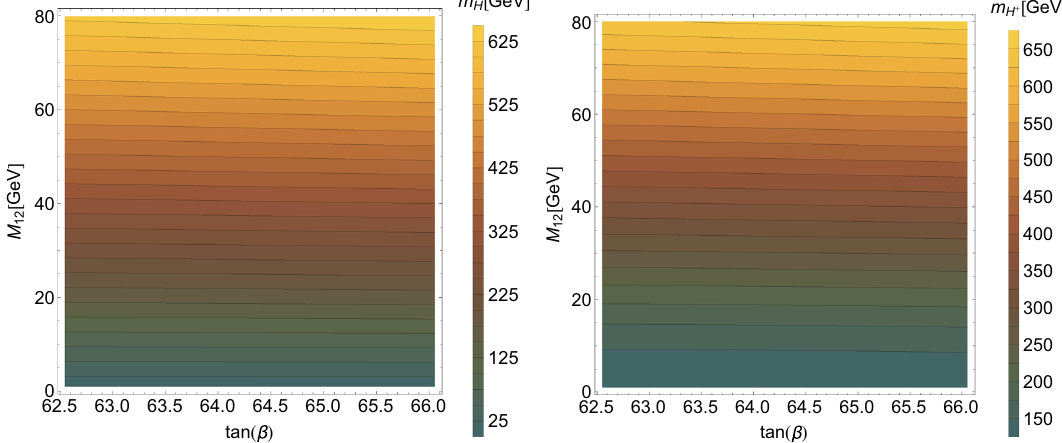
Fig. 8 Masses of M 12 -dependent CP-even neutral scalar m H (left) and charged Higgs boson m H + (right) as a function of tan β and the soft breaking parameter M